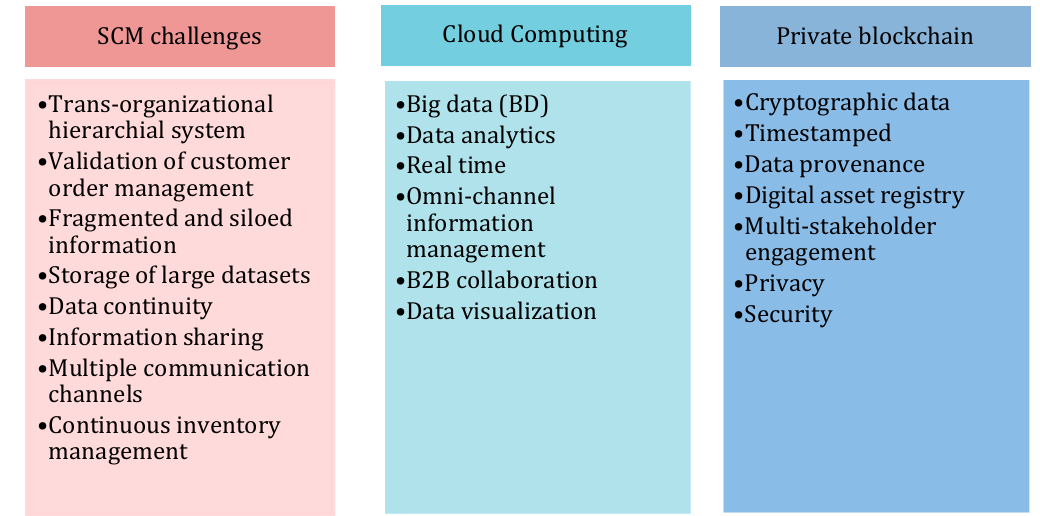
Figure 4. SCM constraints and new enabling technologies for transformation.